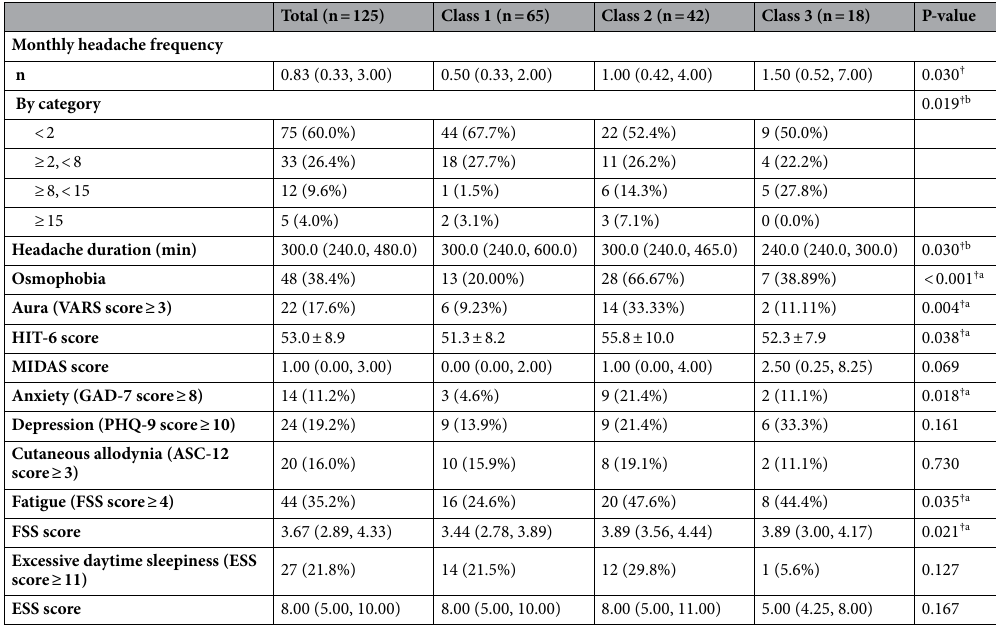
Table 4. Clinical features not included in the diagnostic criteria of migraine in the third edition of the International Classification of Headache Disorders. Data are presented as the mean ± standard deviation, median (interquartile range), or n (%). VARS Visual Analogue Rating Scale, HIT-6 Headache Impact Test- 6, MIDAS Migraine Disability Assessment, GAD-7 General Anxiety Disorder-7, PHQ-9 Patient Health Questionnaire-9, ASC-12 The 12 ‐ item Allodynia Symptom Checklist, FSS Fatigue Severity Scale, ESS Epworth Sleepiness Scale. † Significant P-value. a Significant difference between Class 1 and Class 2 in multiple comparisons. b Significant difference between Class 1 and Class 3 in multiple comparisons. c Significant difference between Class 2 and Class 3 in multiple